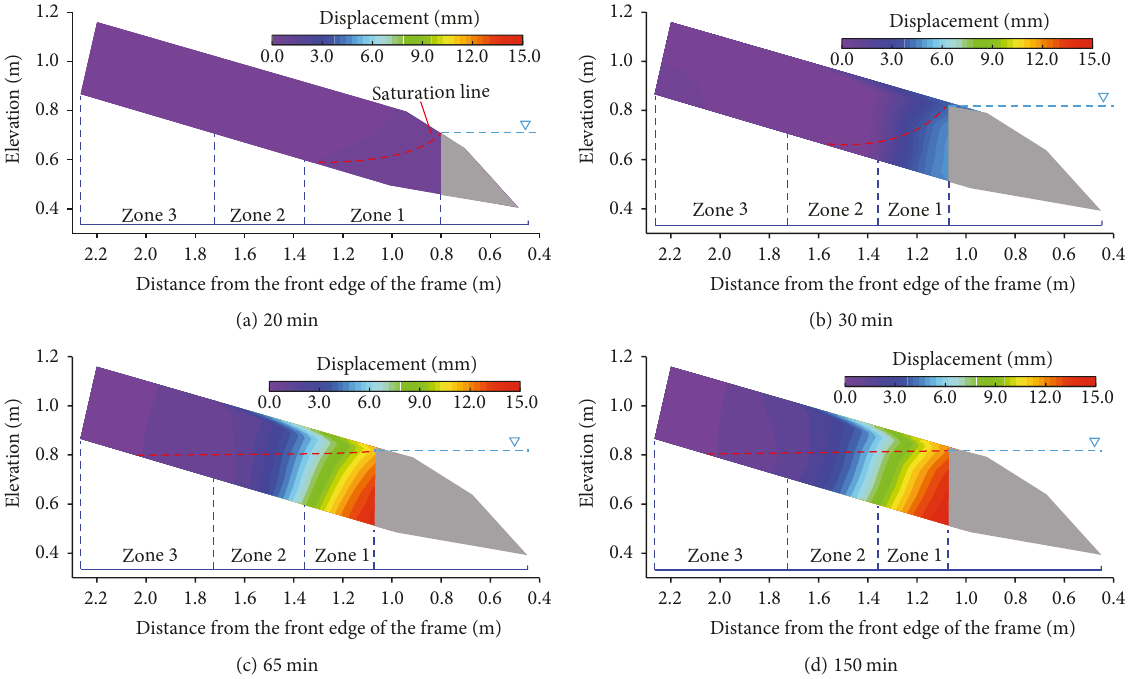
Figure 10: Deformation of the three zones and saturation lines at di ff erent